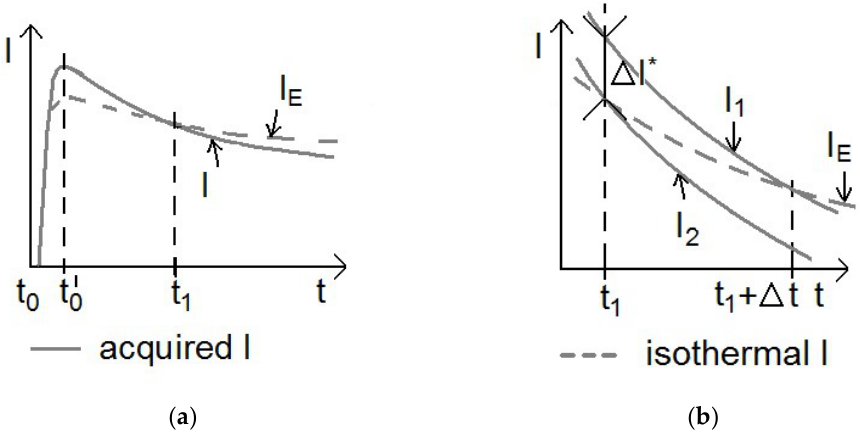
Figure 2. Current time response comparison for various T 0 for ( a ) V n pulse and ( b ) time interval ∆ t . Two identical measurements at distinct ambient temperatures, such that T 01 ≈ T 0 and T 02 ≈ T 0 + ∆ T * with a small temperature difference ∆ T* result in the current I 1 and I 2 , temperature profiles T 1 (X) and T 2 (X), as depicted in Figure 2b, and exhibit the temper- ature profile difference ∆ T ∗ ( X ) = T 2 ( X , t 1 ) − T 1 ( X , t 1 ) ≈ T 2 ( X , t 1 + ∆ t ) − T 1 ( X , t 1 + ∆ t ) ,